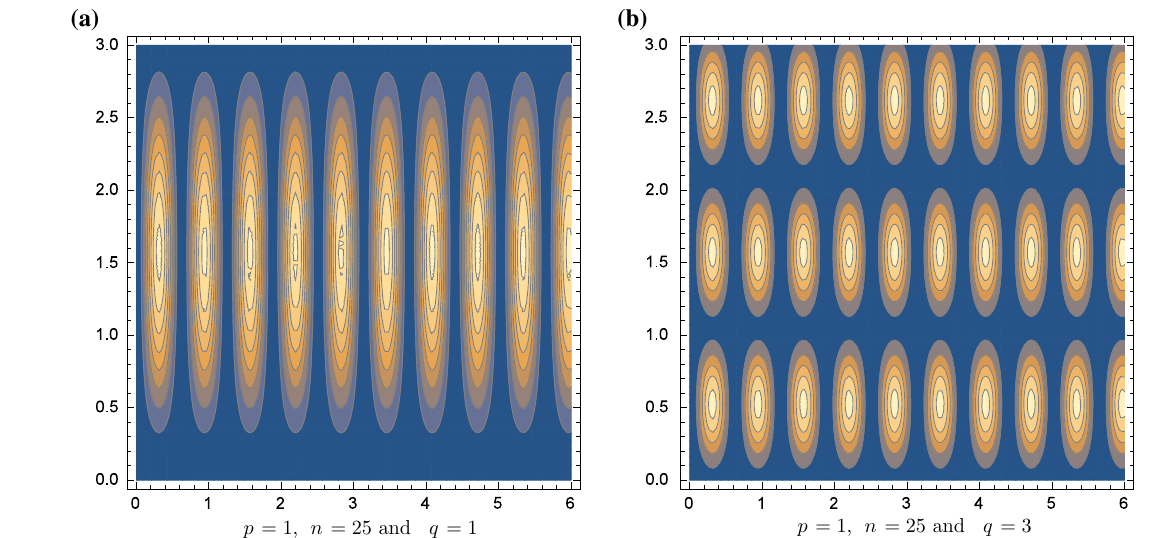
Fig. 1 The left panel ( a ) shows the contour plot of the energy density with p = 1, n = 25 and q = 1 (where the highest energy density is in clear yellow while the lowest is blue). The right panel ( b ) shows the contour plot of the energy with p = 1, n = 25 and q = 3 (in both cases it has been assumed that K = 2 and λ = 1; note that the horizontal axis corresponds to the r direction while the vertical axis to the θ direction).